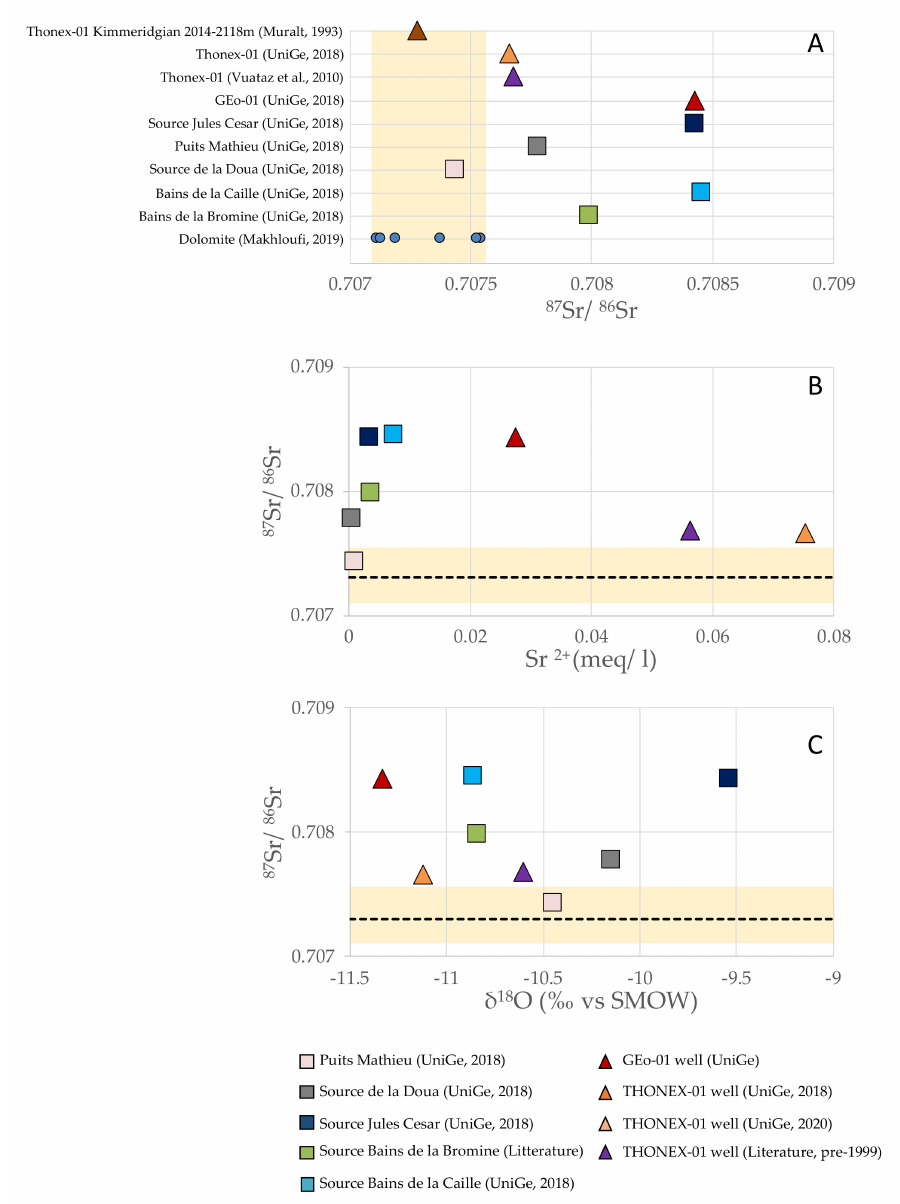
Figure 11. ( A ): Strontium isotopic composition of the collected water samples and Lower Malm (Kimmeridgian) reservoir rock from Thonex-01 well and outcrops in the Jura area; ( B ): Strontium isotopic composition vs. Sr 2+ concentration for the analyzed samples. ( C ): Strontium isotopic composition vs. δ 18 O composition for the analyzed samples The yellow box indicates the 87 Sr/ 86 Sr range for the Kimmeridgian reservoir rock (data from